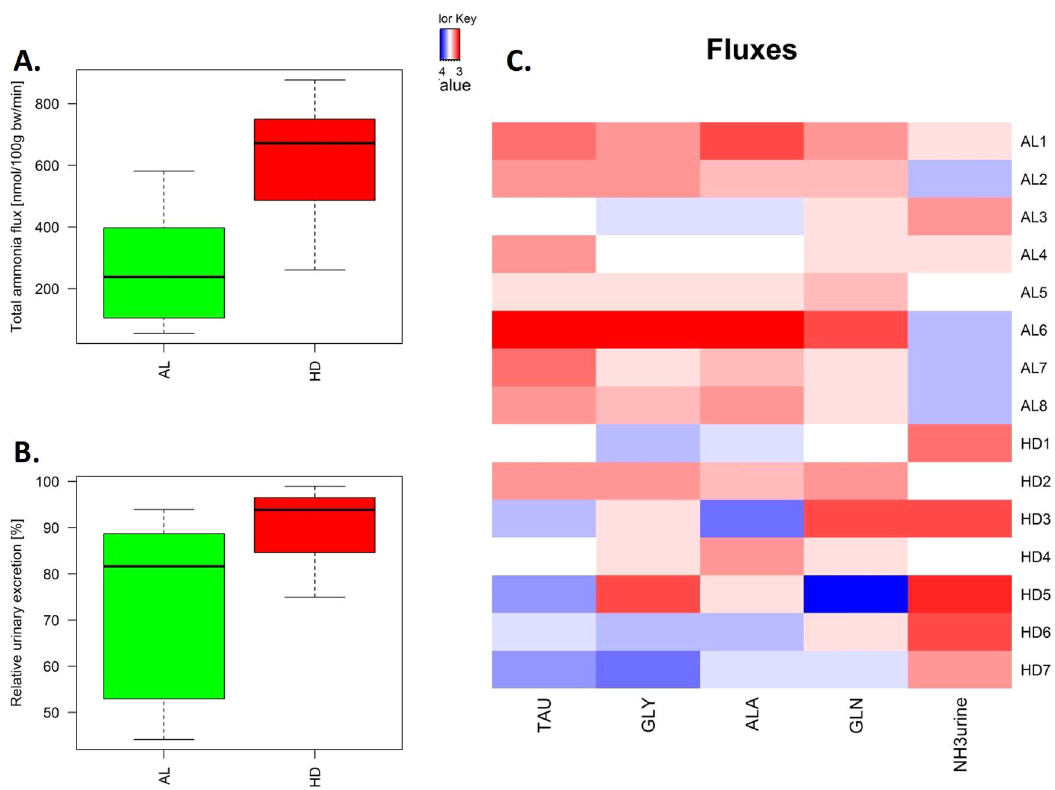
Fig. 2 Pre-hyperammonemic diet increased total renal ammoniagenesis. A Total renal ammoniagenesis. B Percentage urinary excretion relative to total renal ammoniagenesis. C Scaled fl uxes ( P < 0.2), red indicates higher than the mean value, blue lower. This corresponds to clearance from the systemic circulation in kidney (blue) and addition to the systemic circulation (red) for the fl uxes in the veins. In the boxplots, the center lines represent the median; box limits represent upper and lower quartiles; whiskers represent 1.5× interquartile